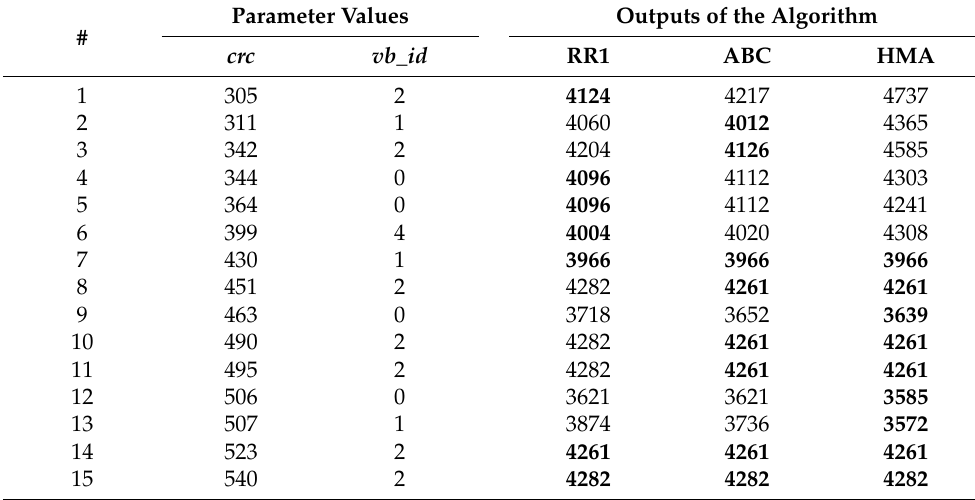
Table 10. The best total costs of 15 independent runs, calculated by the RR1, ABC, and HMA within one minute, after the occurrence of a random vehicle breakdown event in the “egl-e1-A” instance. #